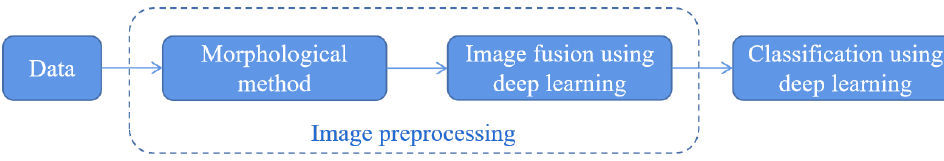
Figure 1. Experimental process.